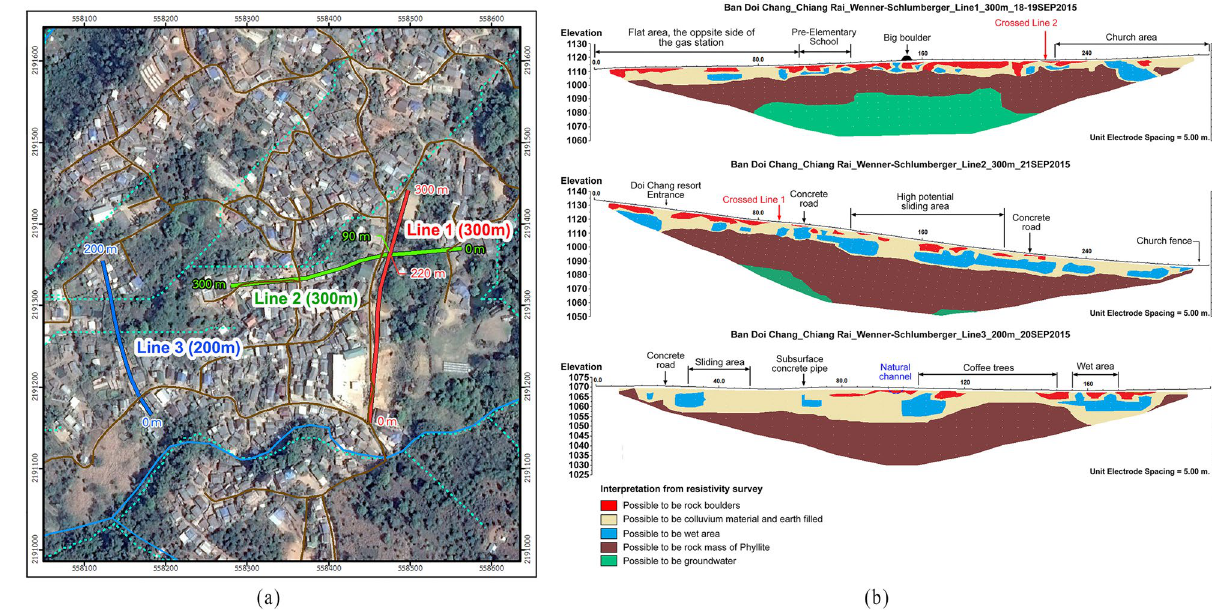
Figure. 6. ( a ) Lines of resistivity survey ( b ) Results of resistivity